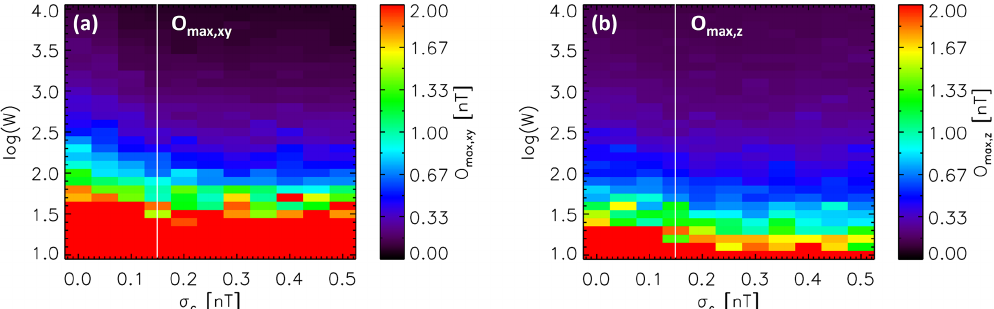
Figure 3. Offset uncertainties O max ,xy (a) and O max ,z (b) as a function of σ c and W . White vertical lines mark σ c = 0 . 15nT in both panels.